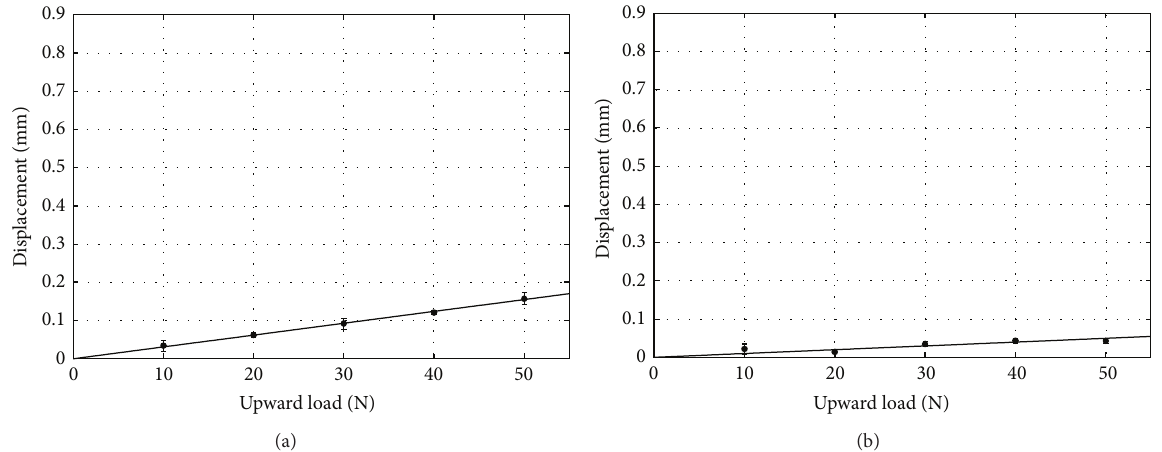
Figure 17: Tensile load-displacement relationship graph of holding device: (a) displacement to upward force on flat plate, (b) graph of displacement to upward force on phantom. Solid line is a fitting line that shows the relationship between load and deformation when the device deforms in the elastic deformation range as a real solid